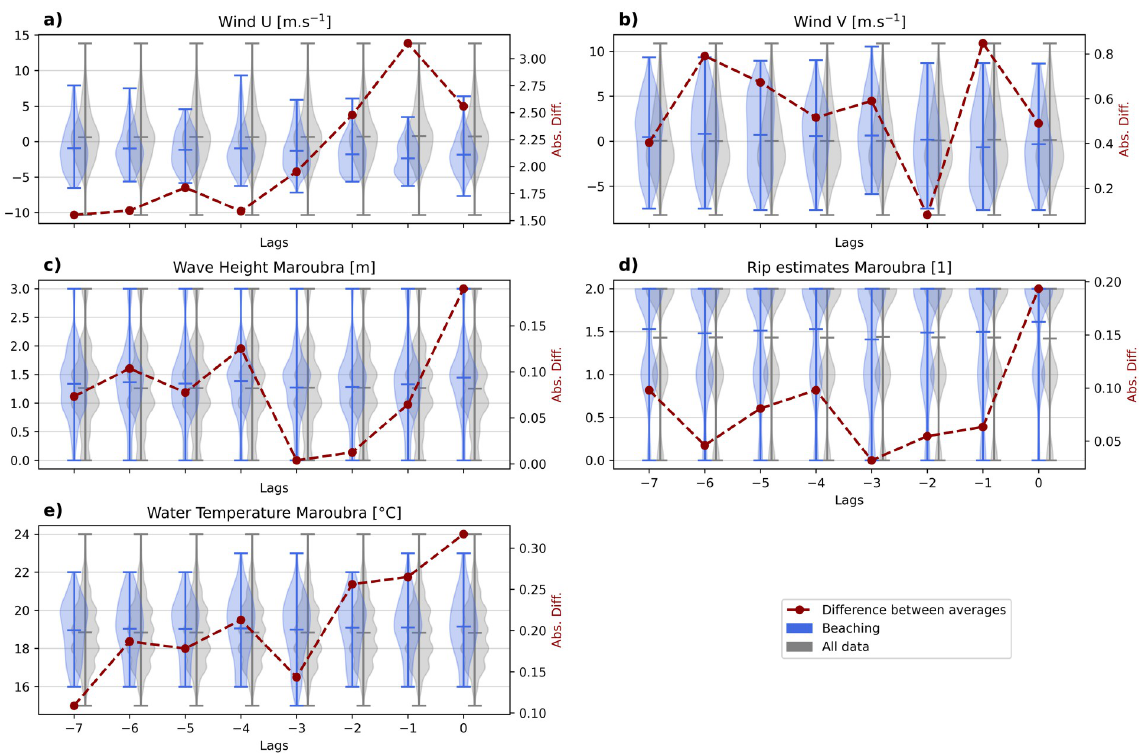
Fig 3. Each subplot shows two violinplots of a variable (U wind, V wind, wave height, rip currents, water temperature) with all data (grey), and data at the condition of a beaching at Maroubra λ days before (blue), for λ going from -7 to 0. For each lag λ , the difference between the average of the two violinplots (beaching condition—all data) is plotted in red dashed